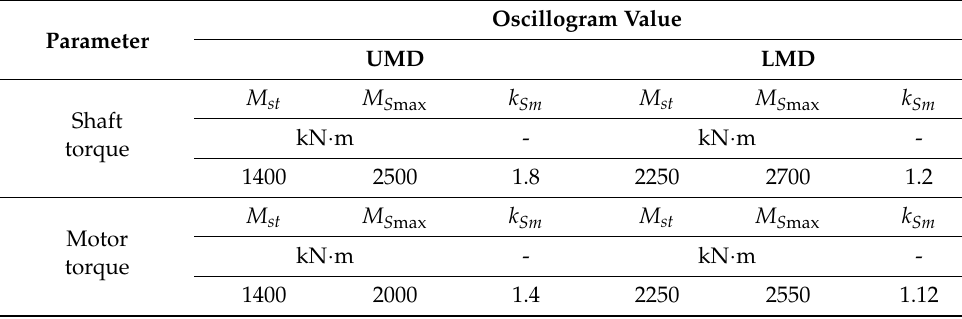
Table 3. Experimental dynamic torque